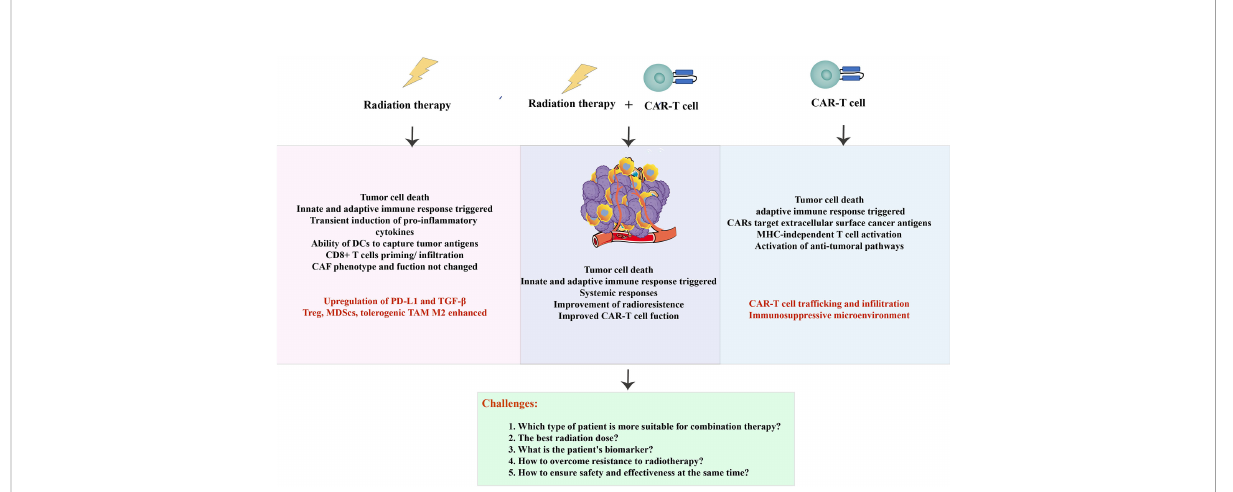
FIGURE 4 Summarized schematic. The advantages and challenges of radiotherapy and CAR-T cells (in red), as well as the bene fi ts and problems to be solved in combination